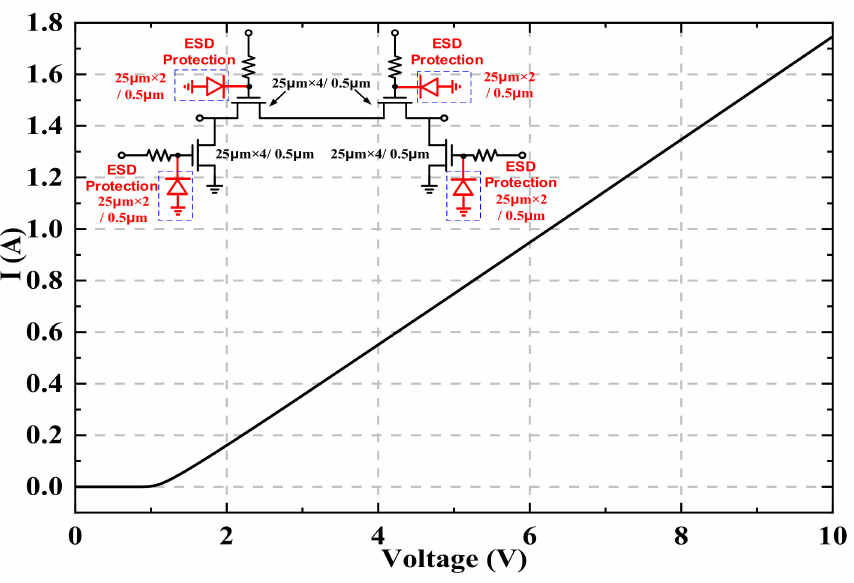
Figure 8. The simulation results of the electrostatic discharge (ESD) protection and the proposed SP2T